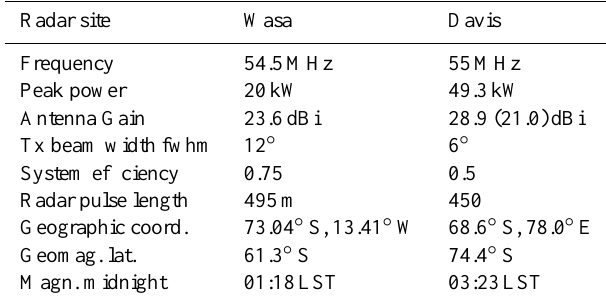
Table 1. Summary of radar